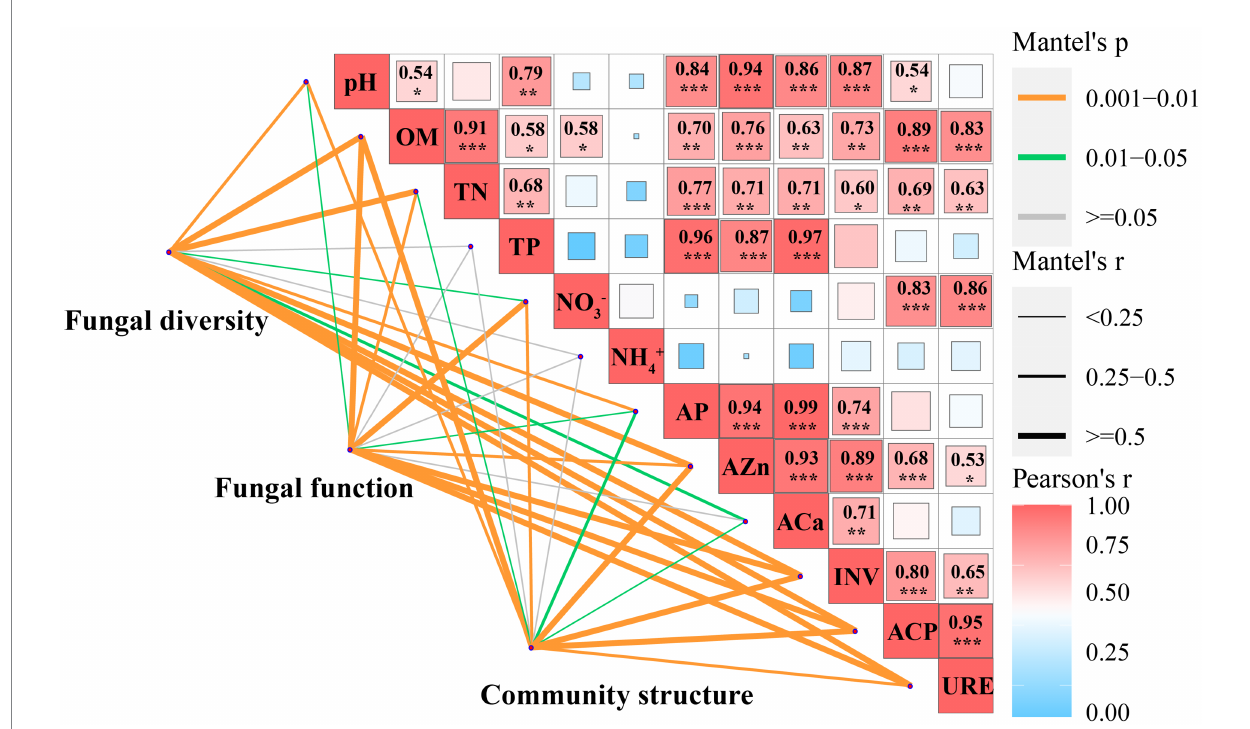
FIGURE 6 Soil biotic and abiotic factors influencing the fungal community diversity, structure, and function in pure eucalypt plantations (CK, E) and mixed plantations (EC, EH). CK, the first rotation of E. urophylla plantations; E, the third rotation of E. urograndis plantations; EC, mixed plantations of E. urograndis and Cinnamomum camphora ; EH, E. urograndis and Castanopsis hystrix ; OM, soil organic matter; TN, total nitrogen; TP, total phosphorus; NO¯ 3, nitrate nitrogen; NH+ 4, ammonium nitrogen; AP, available phosphorus; AZn, available zinc; ACa, available calcium; INV, invertase; ACP, acid phosphatase; URE, urease.